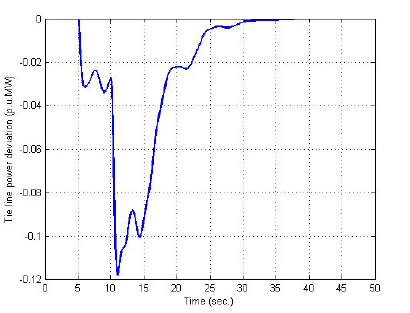
Fig. 8: Frequency deviation of area-2 (Case 2)